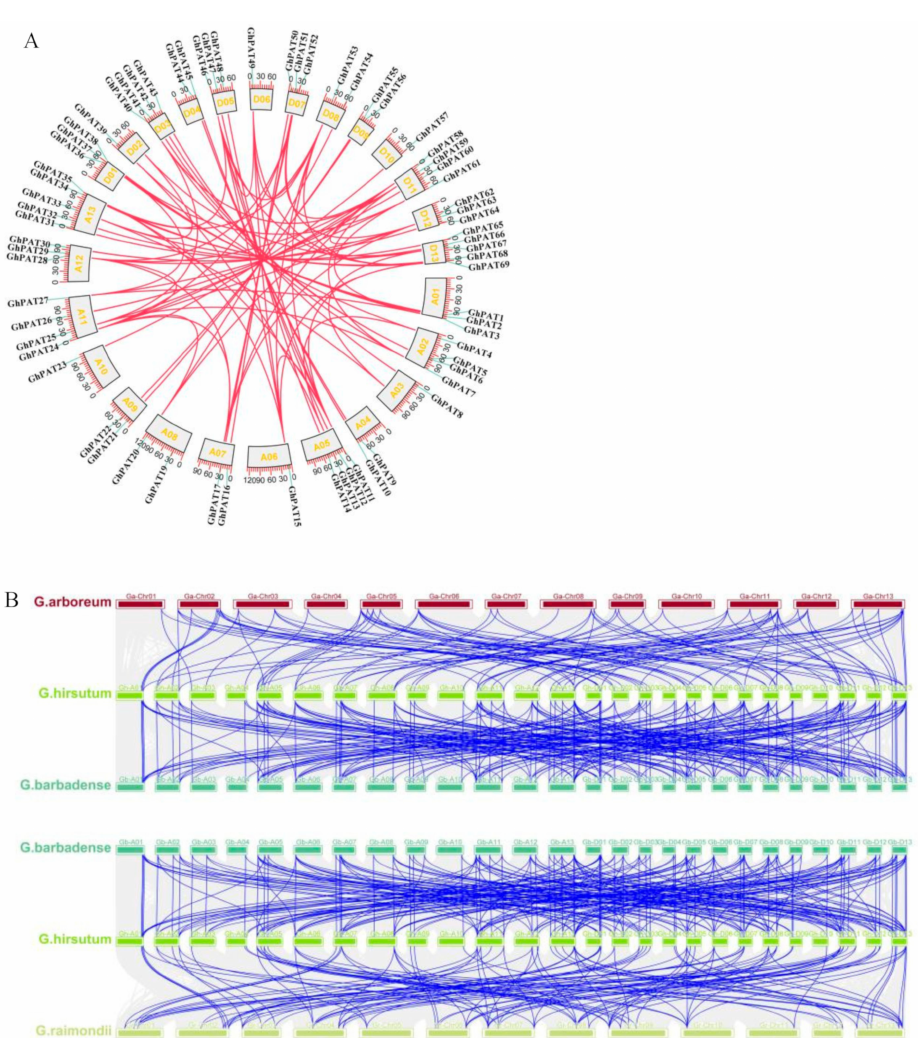
Figure 6. Subgenomic distribution and homozygosity analysis of PAT genes in cotton. ( A ) In- traspecific covariation, synthetic analysis of gene duplicates showing gene pairs between different chromosomes, with gene IDs representing the location of centromeres and the scale on the circles being the megabase; ( B ) Interspecific